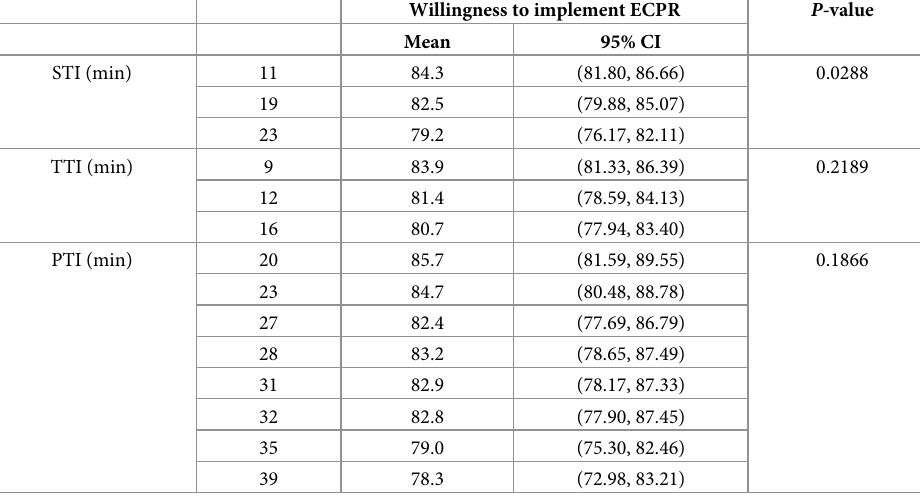
ECMO, Extracorporeal membrane oxygenation; 95% CI, 95% Confidence interval; STI, Scene time interval; TTI, Transportation time interval; PTI, Prehospital time interval.